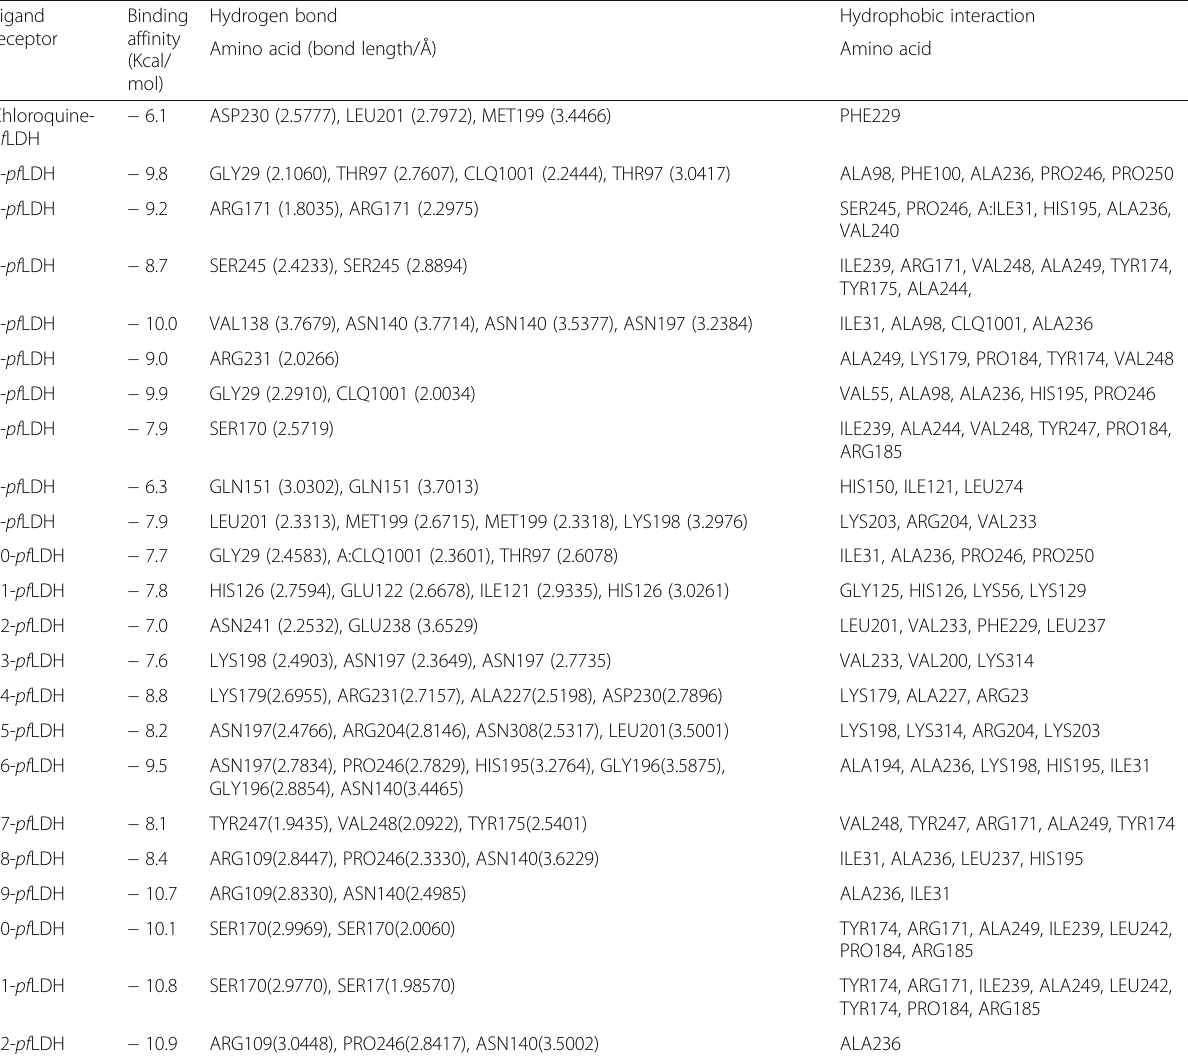
Table 7 Docking result between pf LDH and the selected 1,2,4,5-tetraoxane-8-aminoquinoline